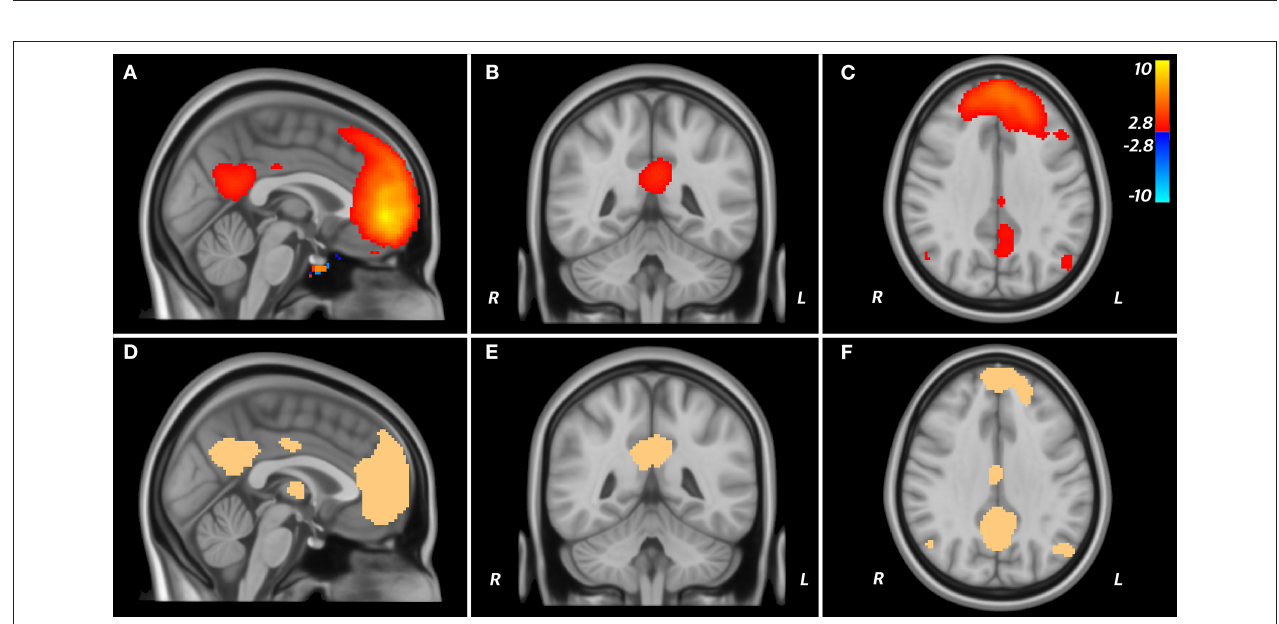
FIGURE 2 | Visual schematic of connectomic analysis with the Tor-PD connectome. (A) A region-of-interest is defined and used as a seed in connectomic analysis. In this example, the seed is the volume of tissue activated by DBS. (B) Across all n = 77 rs-fMRI acquisitions in the Tor-PD connectome, the BOLD timeseries is extracted from the seed region and a separate region in the brain. (C) The average correlation coefficient is computed between the BOLD timeseries in each region. This correlation coefficient represents the strength of functional connectivity between these regions. BOLD, blood-oxygen-level-dependent signal; DBS, deep brain stimulation; rs-fMRI, resting state functional magnetic resonance imaging.